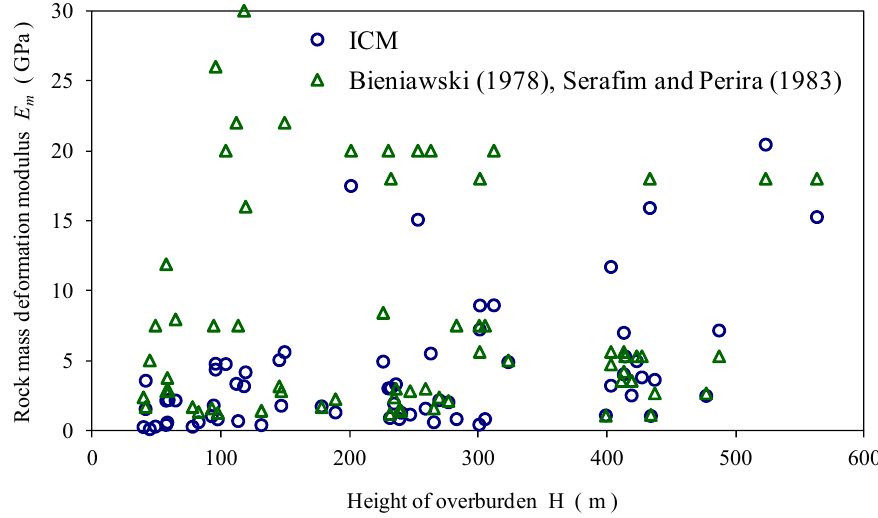
Figure 13. Comparison of the modulus of rock mass between inverse analysis (ICM) and RMR system (from Bieniawski, 1978; Serafim and Perira, 1983) with the height of overburden.